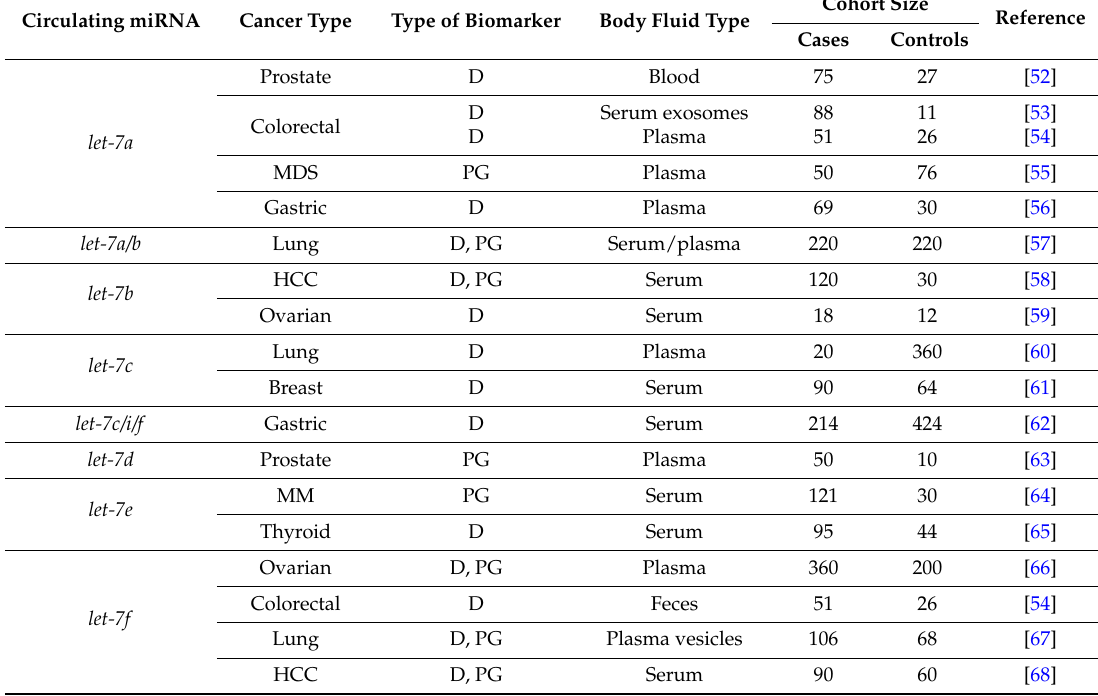
Table 1. Examples of deregulated levels of circulating miRNAs in various malignancies proposed to have either diagnostic and/or prognostic value. MDS: Myelodysplastic syndrome; HCC: Hepatocellular carcinoma; MM: Multiple myeloma; DLBCL: Diffuse large B-cell lymphoma; HL: Hodgkin lymphoma; CNS: Central nervous system; AML: Acute myeloid leukemia; CLL: Chronic lymphocytic leukemia; ATL: Adult T-cell leukemia; BAL: Bronchoalveolar lavage; D: Diagnostic; PG: Prognostic; and PD: Predictive of